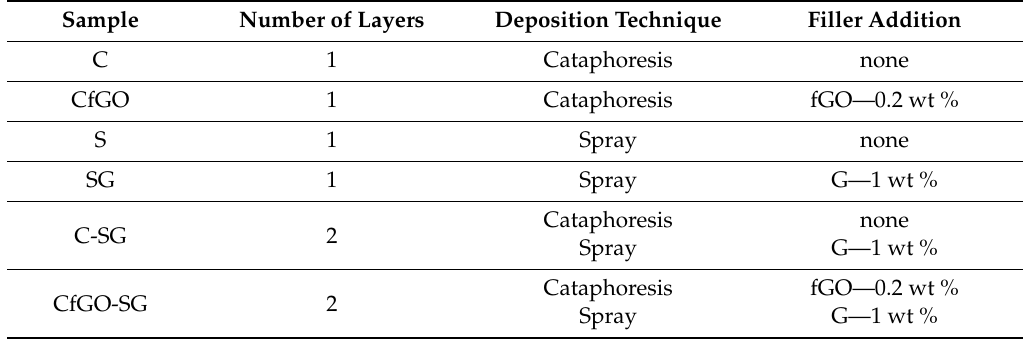
Table 1. Samples labelling, with the relative number of layers, deposition techniques and filler addition.